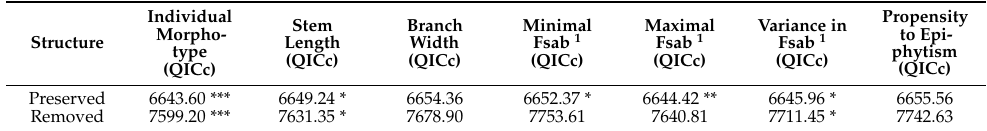
Table 1. Quasi-likelihood information criterion (QICc) evaluations for the individual models for mosses with preserved/removed structures based on their individual morphotypes or their various morphological or ecological